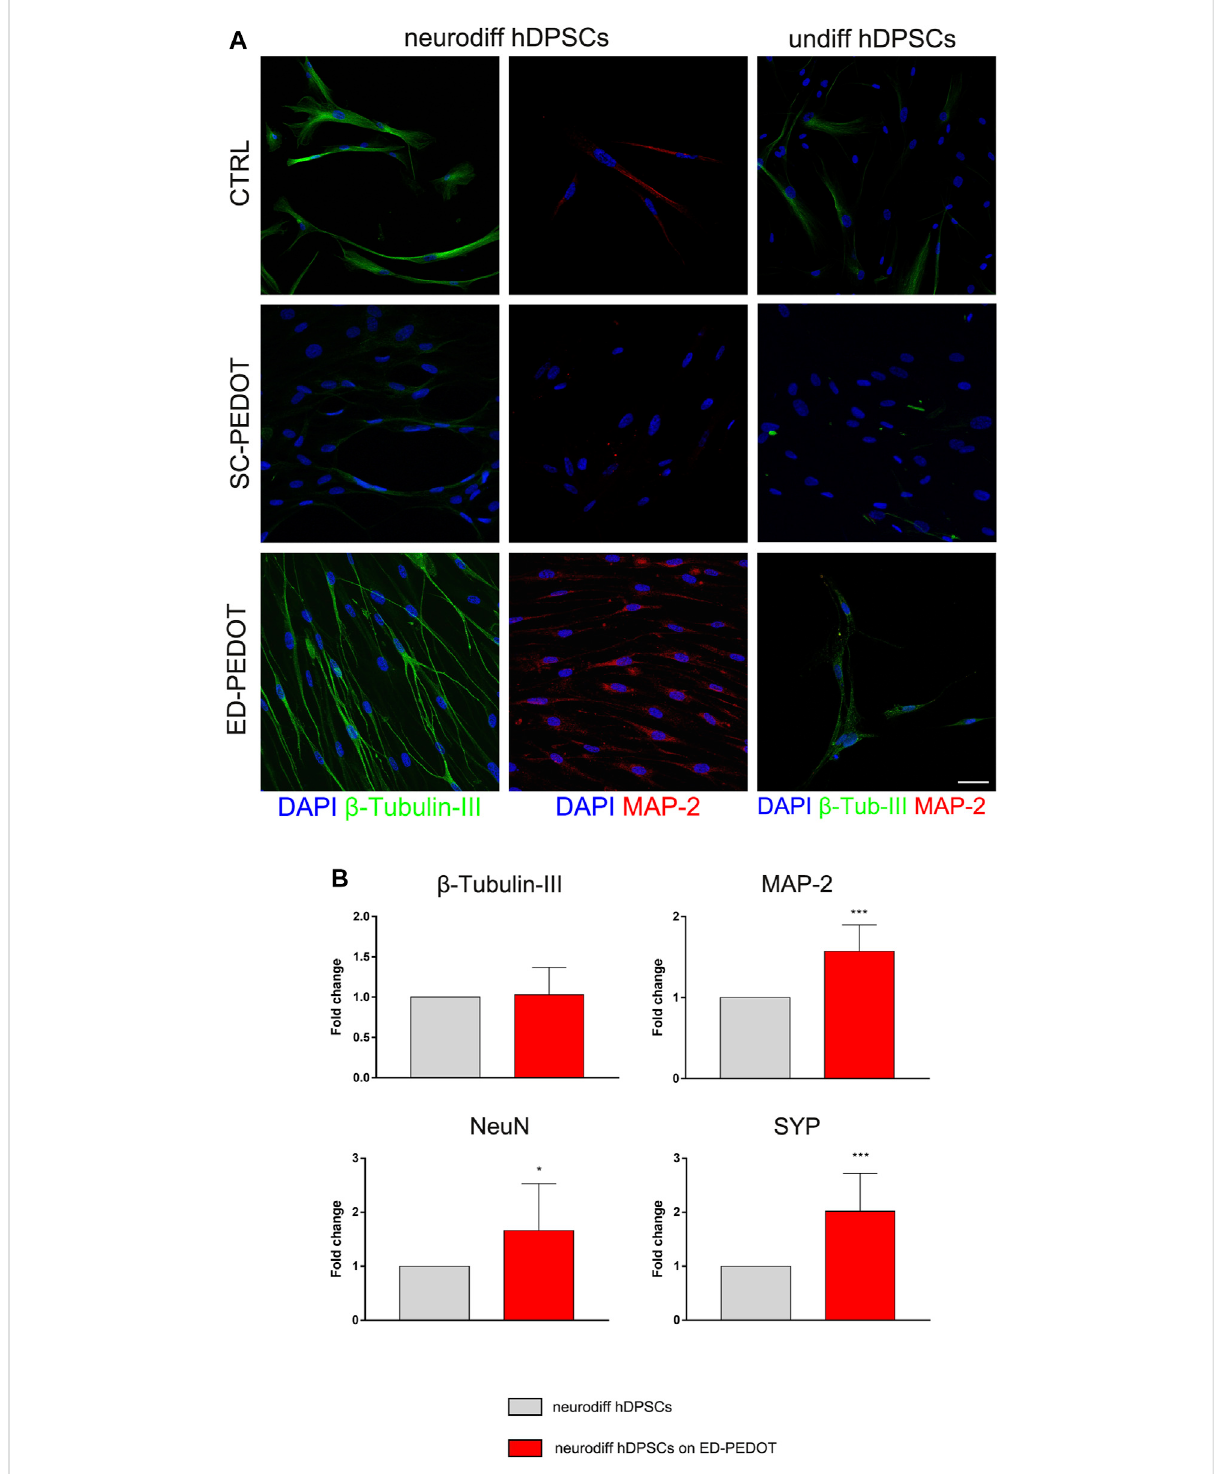
Evaluation of neurogenic differentiation of hDPSCs on PEDOT: PSS fi lms. The expression of the neuronal markers β — Tubulin-III (green) and MAP-2 (red) in hDPSCs cultured in neurogenic medium for 7 days on both types of PEDOT:PSS fi lms are shown by representative immuno fl uorescence images. Nuclei were counterstained with DAPI. hDPSCs differentiated on plastic culture plates were used as controls. Scale bar: 20 μ m (A) . Real-time PCR analysis showing fold increase of mRNA levels of β — Tubulin-III, MAP-2, NeuN and Synaptophysin (SYP) in hDPSCs after 3 weeks of neurogenic induction on ED-PEDOT fi lms. Data represent mean ± SD of fold change obtained from three independent experiments. * p < 0.05, *** p < 0.001 vs. neurodiff hDPSCs (i.e., on plastic culture plates) (B)